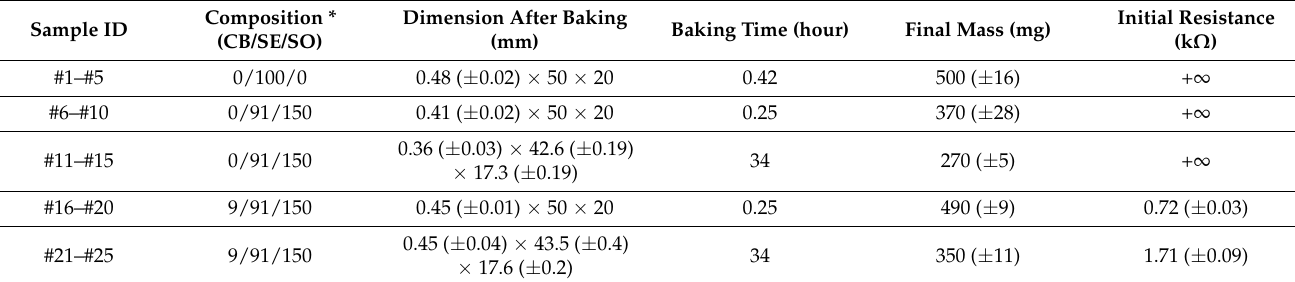
Table 2. Sample specification and processing parameters for strain gauge